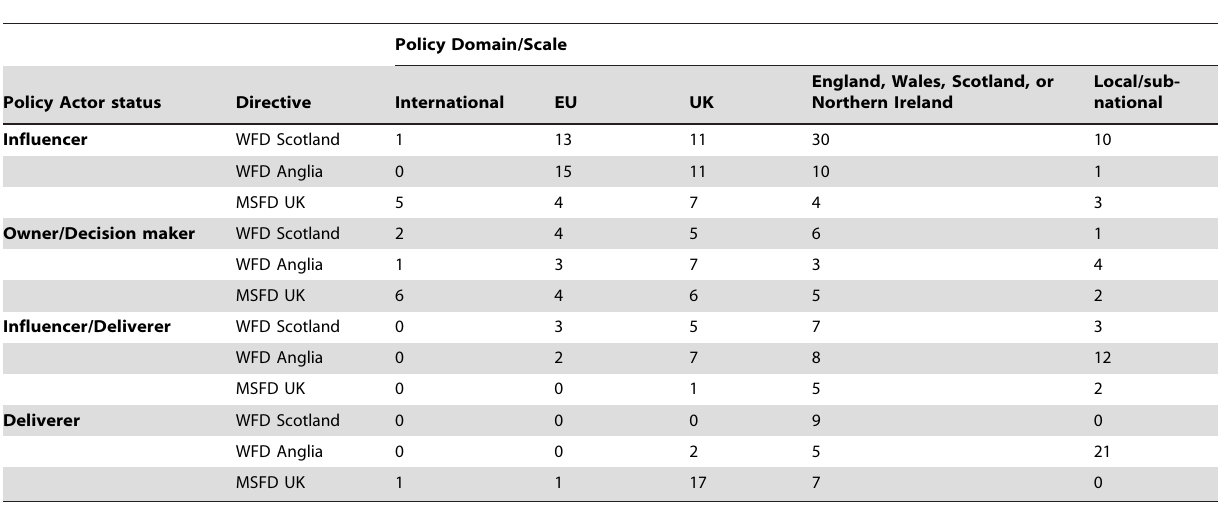
Table 3. Summary results of policy actors for the three case